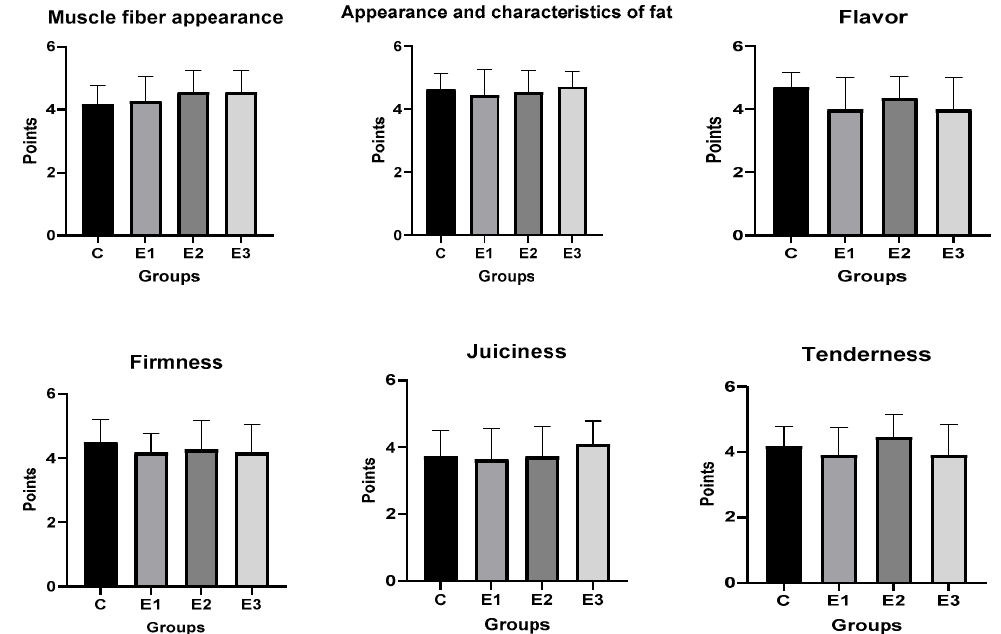
Figure 3. Sensory characteristics of chicken’s thigh (mean of points) Main effects of diets are presented in each graph (Prism Graph 9.02). Data are presented as mean ± SEM of points (n = 6 samples/group). No superscript denotes any statistical significance ( p > 0.1234). C: control diet; E1: experimental diet supplemented with 200 µg/kg diet CrPic + 0.25 g vitamin C (VC)/kg diet; E2: experimental diet supplemented with 200 µg/kg diet CrPic + 0.025 g Zn/kg diet; E3: experimental diet supplemented with 200 µg/kg diet CrPic + 10 g creeping wood sorrel powder (CWS)/kg diet.